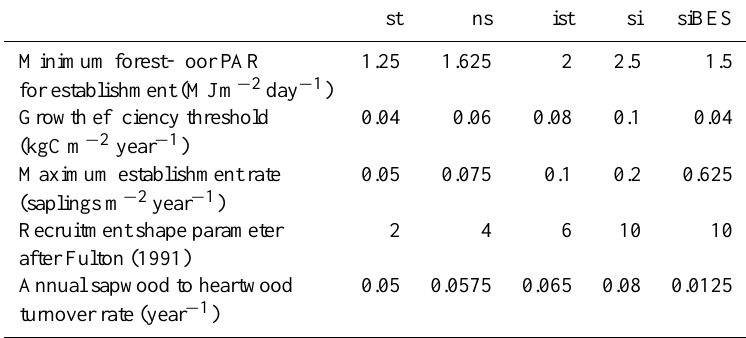
Table D8. Shade tolerance parameters. The affiliations to species are given in Table D10. st: shade tolerant; ns: nearly shade tolerant; ist: intermediate shade tolerant; si: shade intolerant; siBES: shade-intolerant boreal evergreen shrubs. st